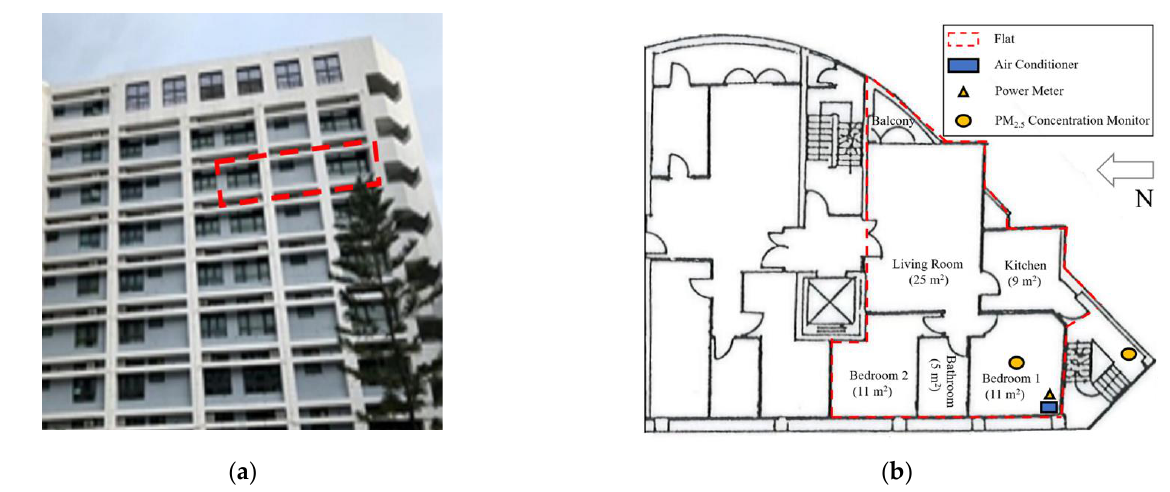
Figure 2. ( a ) The measured flat; ( b ) the floor plan of the measured flat.